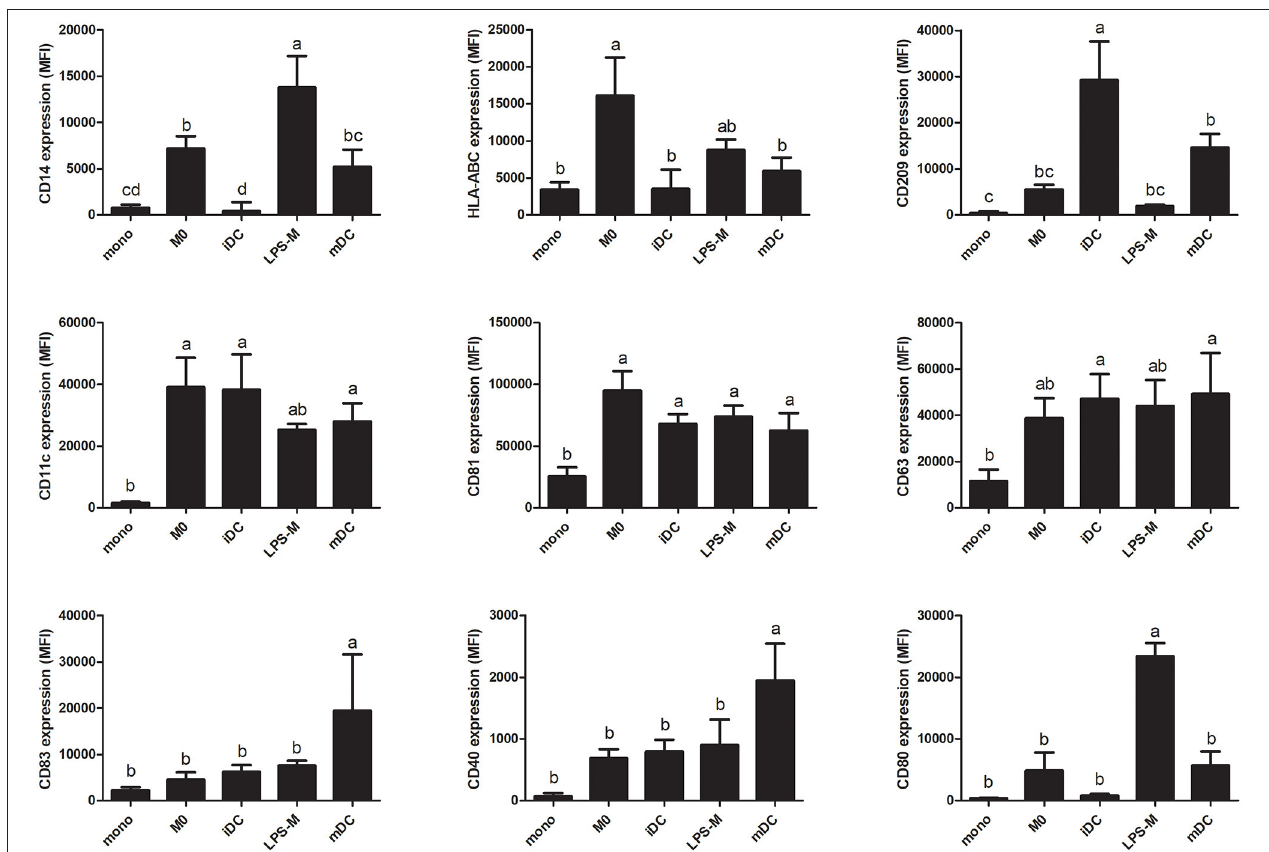
FIGURE 4 | THP-1-derived macrophage- (M0) and dendritic-like cells (iDC) and their LPS-stimulated forms LPS-M and mDC showed different surface marker profiles compared to monocytes. THP-1 monocytes were non-treated or differentiated into M0 and iDC and/or stimulated with LPS yielding LPS-M and mDC, respectively. Expression of surface markers was analyzed through staining with fluorescent-labeled antibodies and MFI was measured by flow cytometry. The results represent the mean MFI ± SD of 5 independent experiments. The statistical differences were calculated with Fishers Least Significant Difference (LSD) test and bars with different letters represent significant differences ( p <